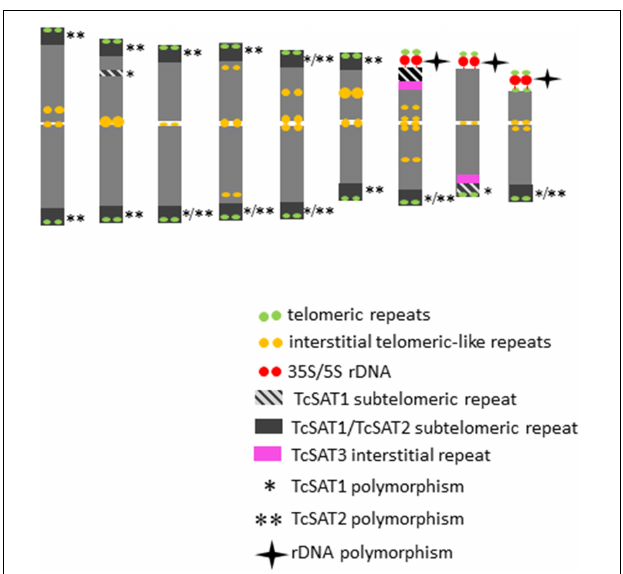
FIGURE 4 | An ideogram of T. cinerariifolium chromosomes with marked localization of 35S/5S rDNA, Arabidopsis -type (TTTAGGG) n telomeric repeats, as well as TcSAT1, TcSAT2 and TcSAT3 satellite repeats. Polymorphic TcSAT1 and TcSAT2 sites are marked by asterisk and double asterisk, respectively. Polymorphic rDNA sites are marked with star. This ideogram was generated based on the FISH information from Figure 2 .